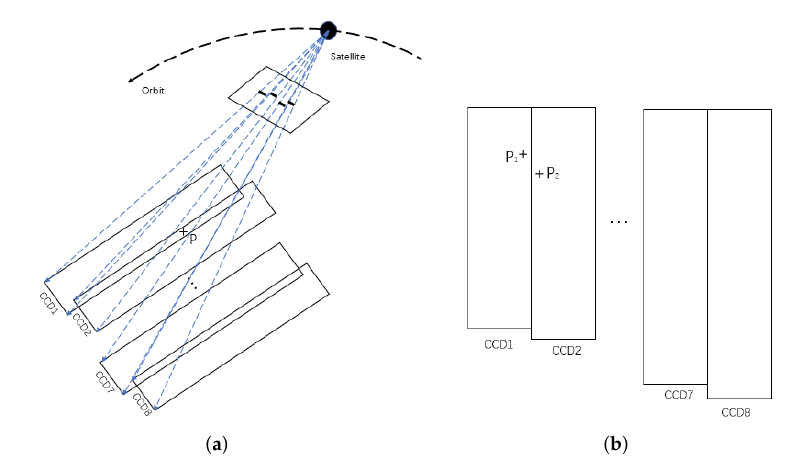
Figure 5. Rigorous sensor model of stitched CCD imagery: ( a ) rigorous model in object-space and ( b ) rigorous model in